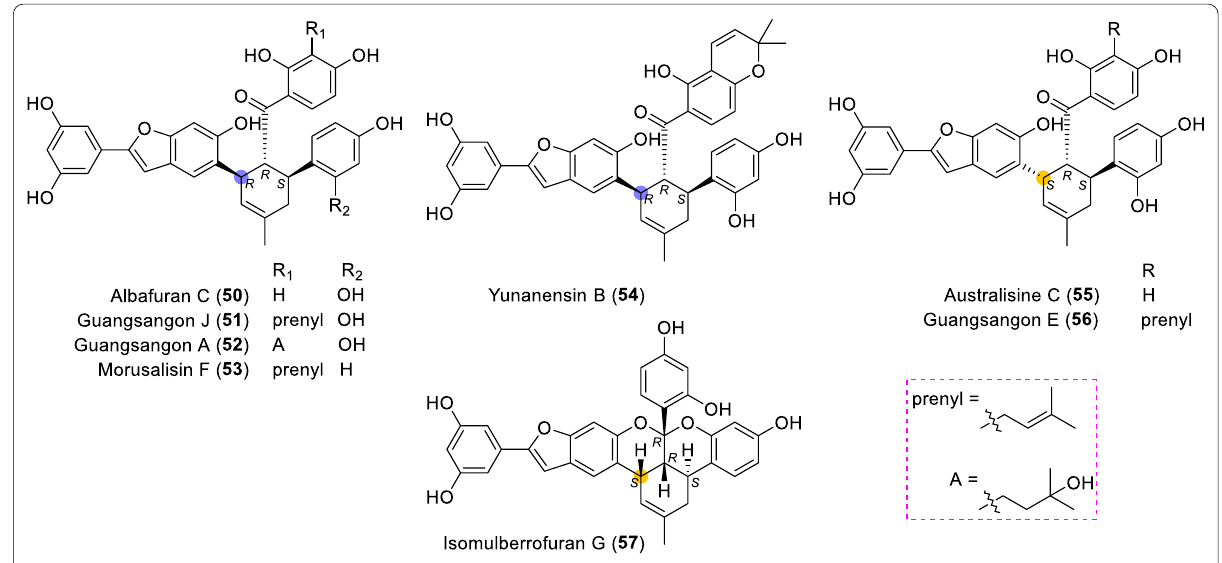
Fig. 4 Structures of dehydroprenyl‑2‑arylbenzofuran type MDAAs (Type A, continued